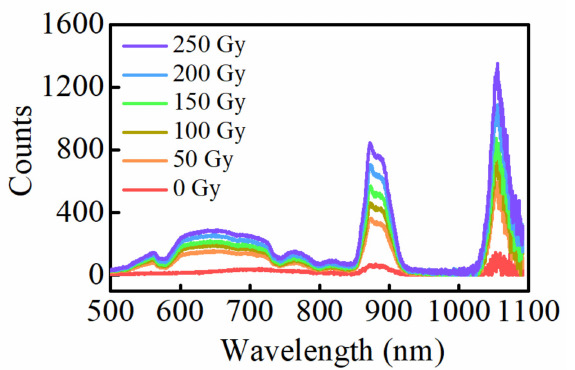
Figure 3. The fluorescence spectra of the Ag–Nd-codoped phosphate glasses at different radiation doses (310 nm